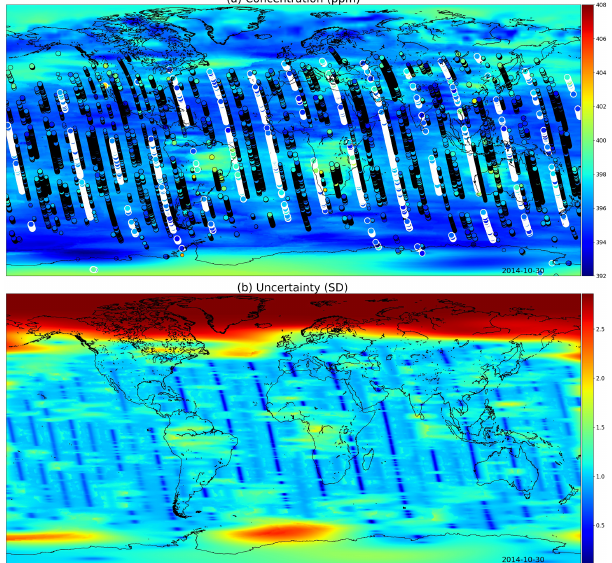
Figure 10. (a) XCO 2 posterior mean values and (b) their uncertain- ties on 10 June 2016. While photosynthesis in the Northern Hemi- sphere is already reducing the carbon dioxide concentrations glob- ally, the observations condition the Gaussian process to higher mean values than in Fig. 9. In the summer months the uncertainty stays high close to the South Pole. These fields include latitudes up to 85 ◦ S and 85 ◦